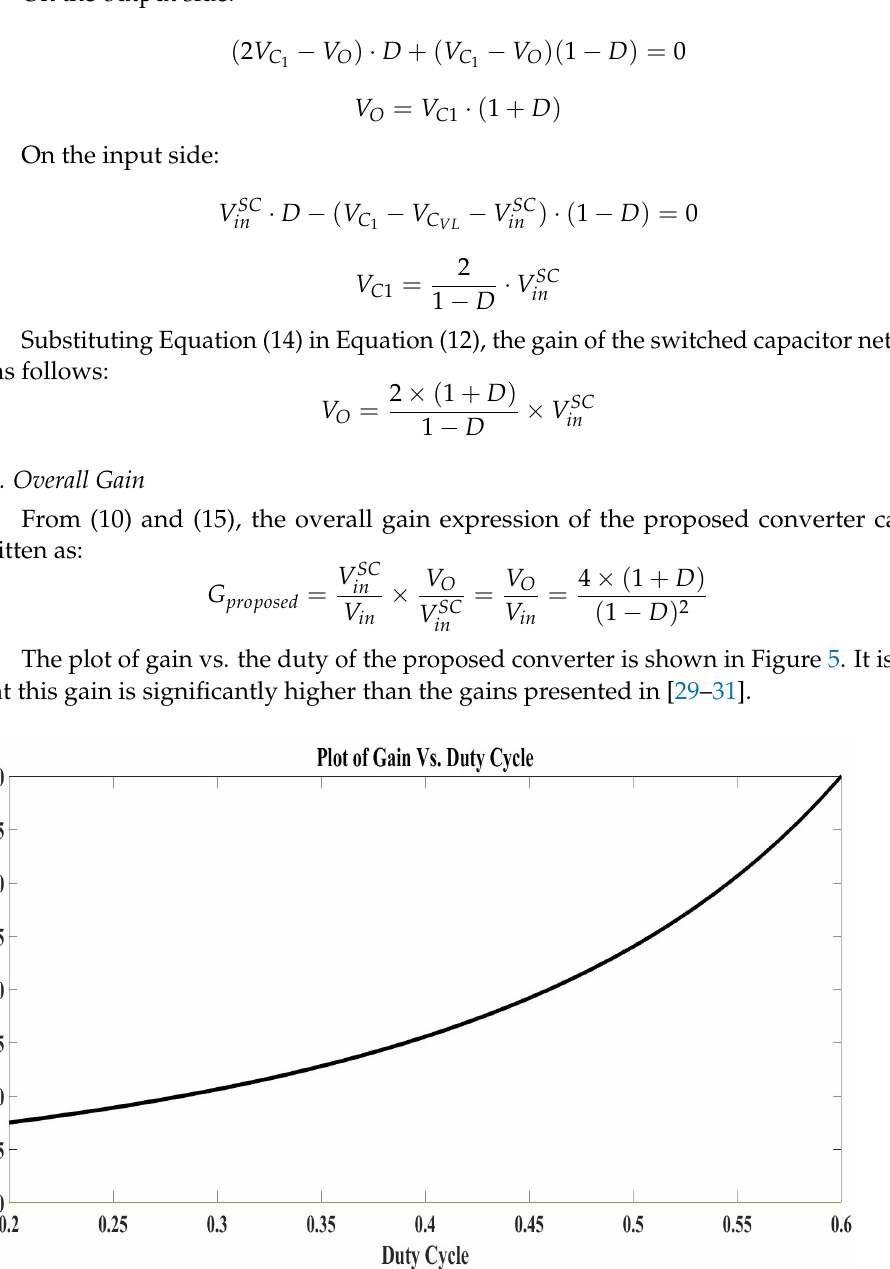
Figure 5. Gain plot of the proposed